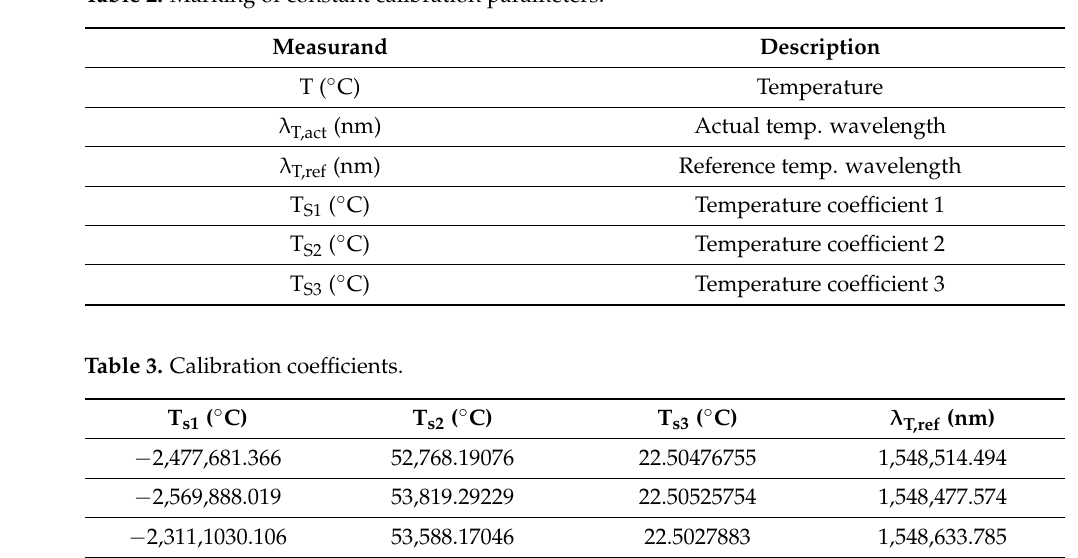
Table 2. Marking of constant calibration parameters.